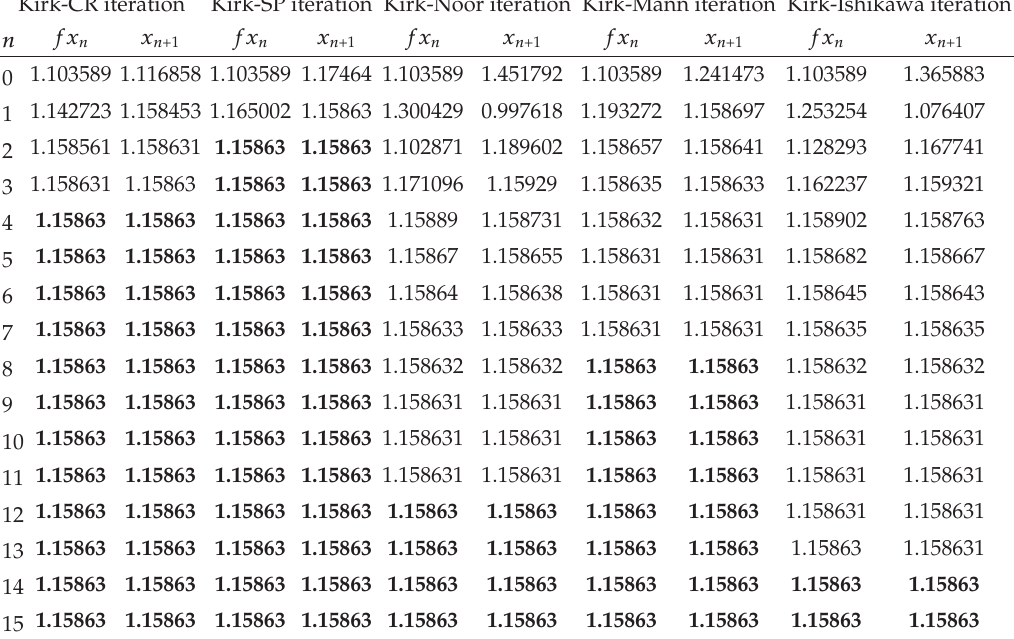
Table 2: Increasing